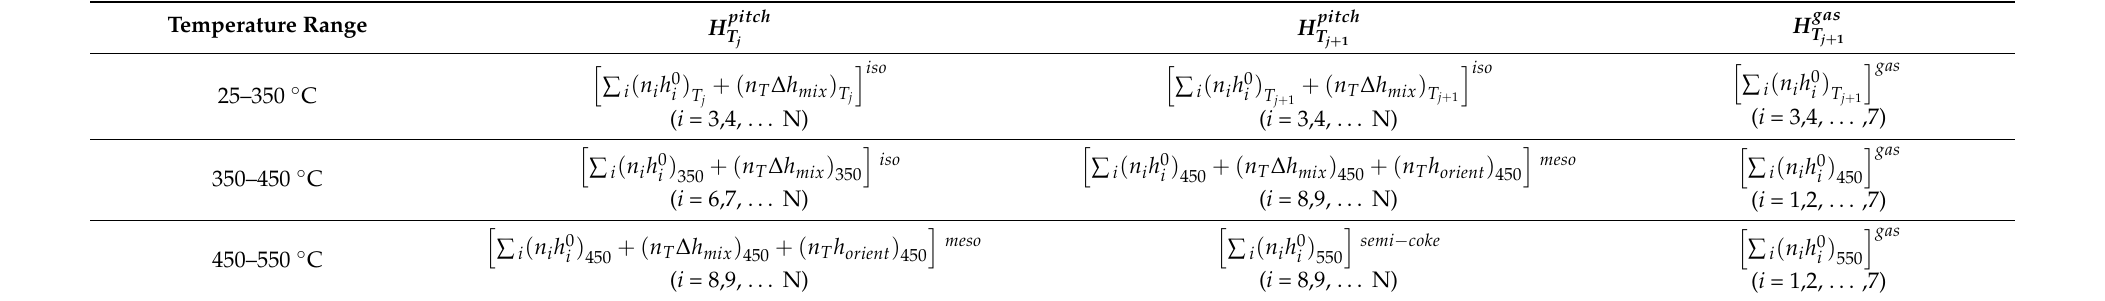
Table 5. Definition of different terms in Equations